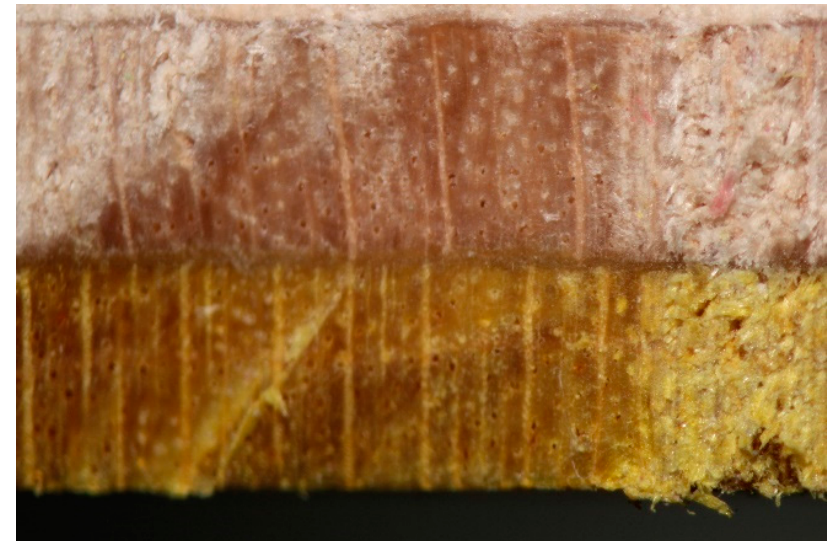
Figure 23. Species Identification Sample 3 20×.